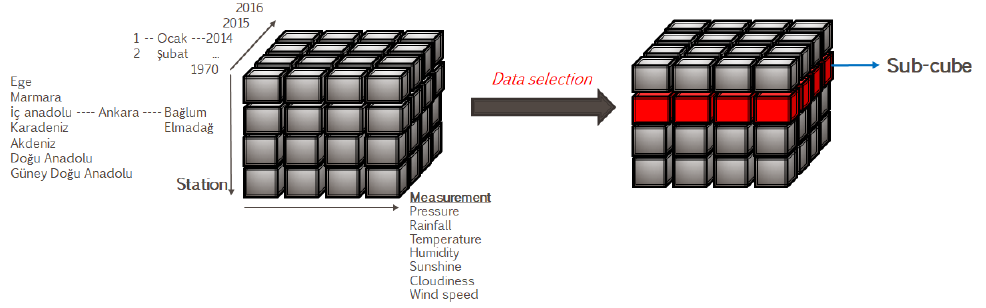
Figure 3. Subcube from SOLAP data